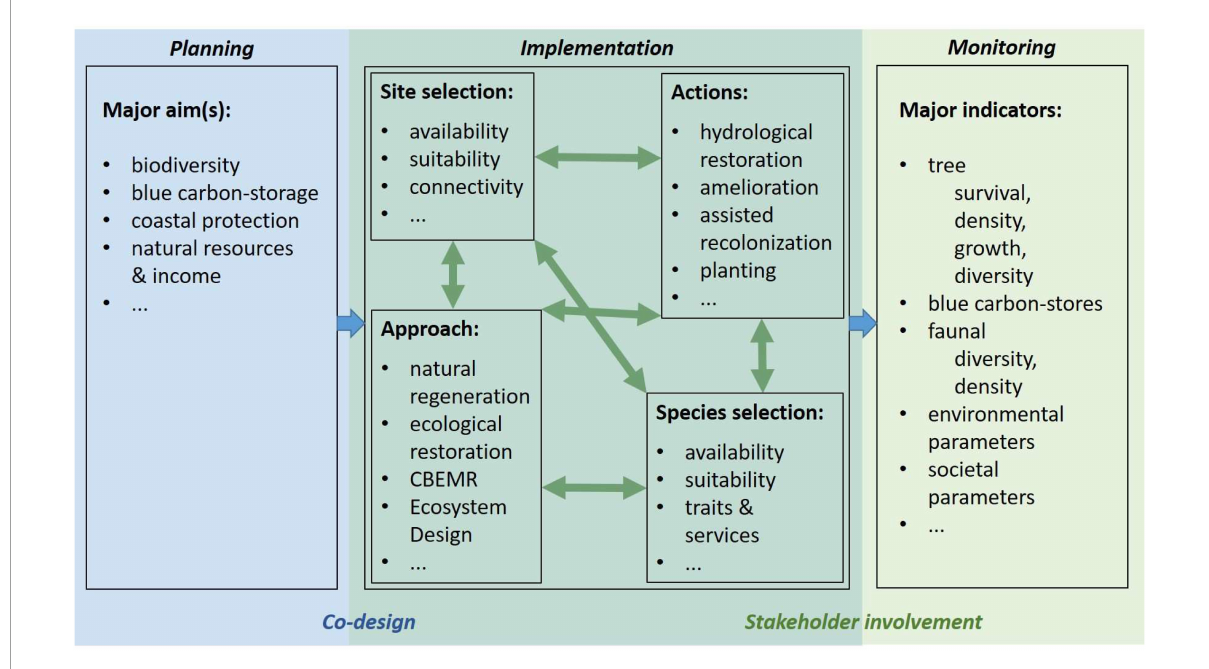
FIGURE3 Conceptual scheme of major steps and decisions during planning, implementing, and monitoring the success of, mangrove (re-)establishment. Blue arrows depict the progress of action, green arrows show dependencies of decisions.